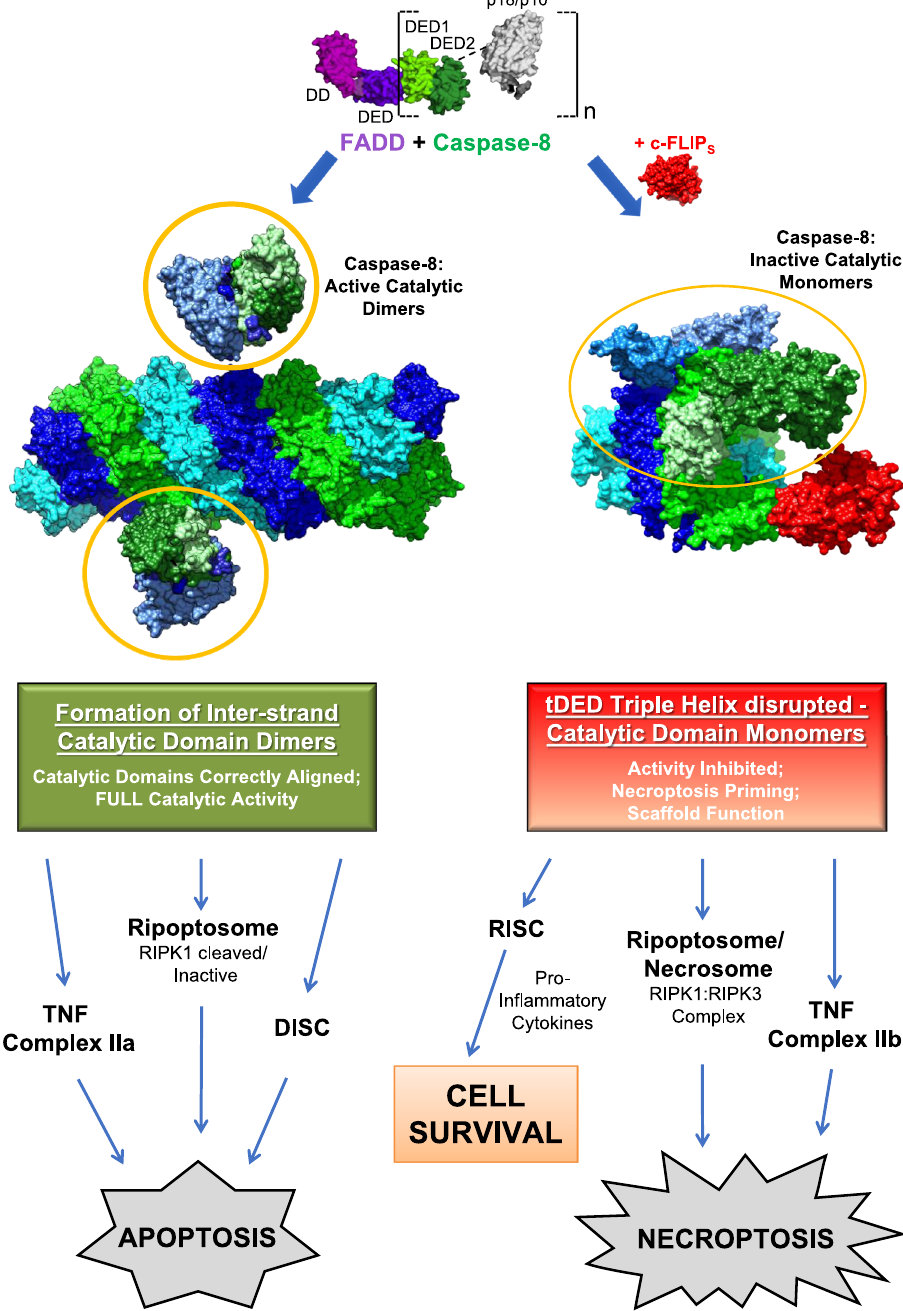
Fig. 8 Cryo-EM structural analysis of FADD:Caspase-8 complexes de fi nes the catalytic dimer architecture required for co-ordinated control of cell fate. FADD-nucleated complexes extend by sequential addition of Caspase-8 molecules, with all 3 strands within the tDED helix extending simultaneously. The fi lament extends in such a way that only the catalytic domains of Caspase-8 molecules on aligned strands of the triple helix (Strand 1, blue and Strand 2, green) are orientated correctly to enable antiparallel dimerization and full catalytic activation. The resultant catalytically active FADD:Caspase-8 complex triggers apoptosis via several key signaling platforms, namely TNF Complex IIa, the Ripoptosome and the DISC (Death-Inducing Signaling Complex). Recruitment of the tDED regulator, c-FLIP S , to the FADD:Caspase-8 complex signi fi cantly alters the molecular architecture of the complex and inhibits Caspase-8 enzymatic activity via a hitherto unknown dual mechanism. A non-canonical interaction of c-FLIP S tDEDs within the helical fi lament alters the orientation of the aligned strands, thus preventing recruitment of further Caspase-8 molecules to adjacent strands and causing tDED fi lament termination. Due to the altered topology of the complex, the catalytic domains of Caspase-8 cannot align correctly or dimerize and therefore remain as inactive monomers. This signi fi es a pivotal switch in the canonical role of Caspase-8, whereby Caspase-8 instead functions as a scaffold for complexes signaling for RIPK1/RIPK3-driven necroptosis (via the Ripoptosome, Necrosome and TNF Complex IIb) or alternatively promotes cell survival, e.g., via the RISC (Receptor-Induced Signaling